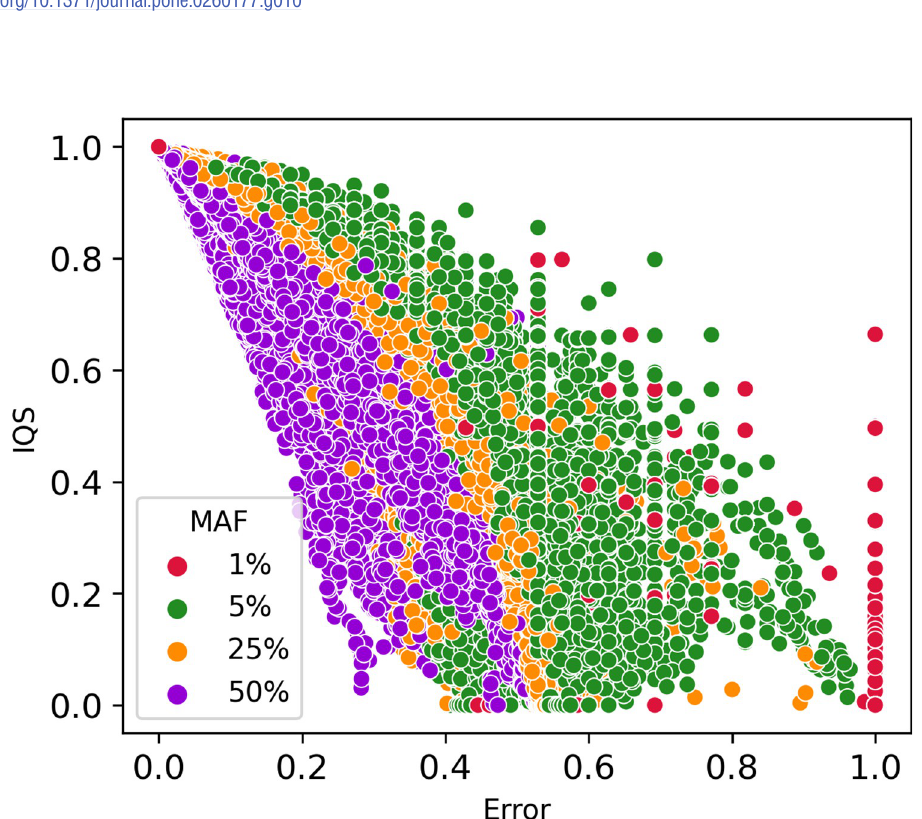
Fig 11. Minor allele frequency (MAF) stratification of imputed variants. Dots are clustered following minor allele frequency stratification. The dots clustered in the right-down corner of the figure have low IQS and high error rate, while dots in the left-high corner have high IQS and low error rate. Each dot represents the average IQS and error rate for a specific marker imputed with one phasing tool-imputation tool combination.